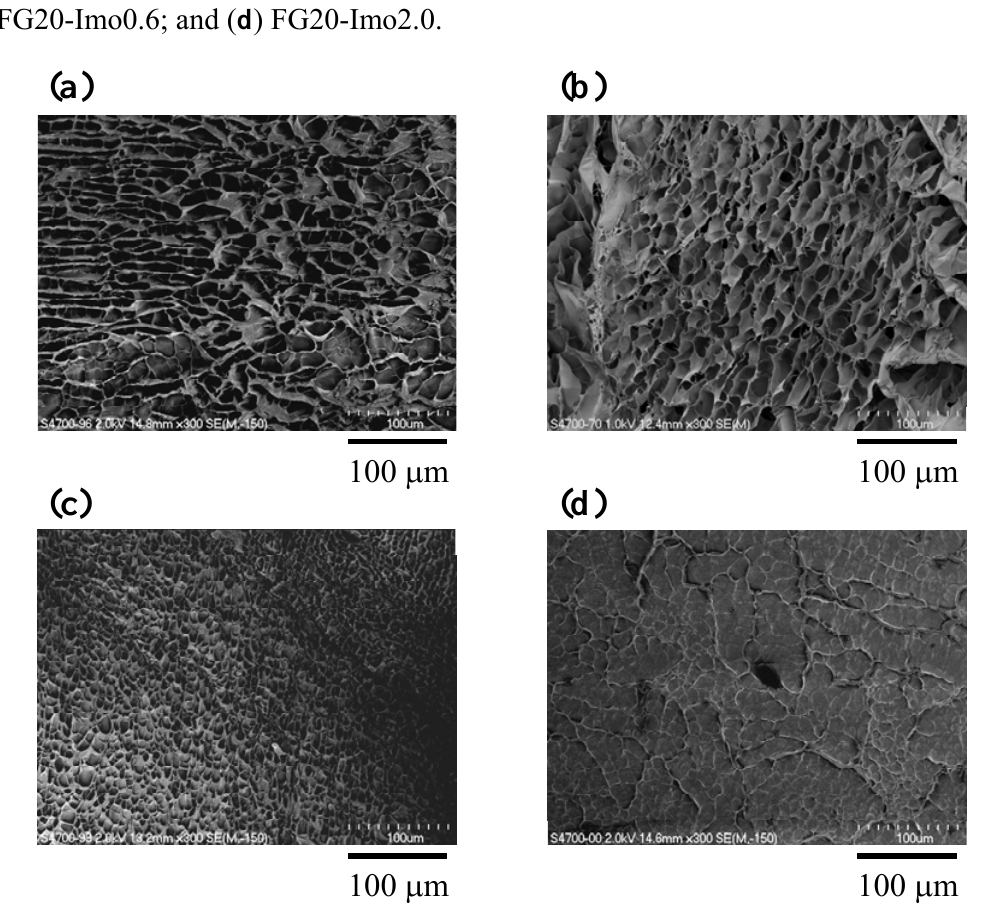
Figure 4. TEM photographs of composite gels sectioned using a